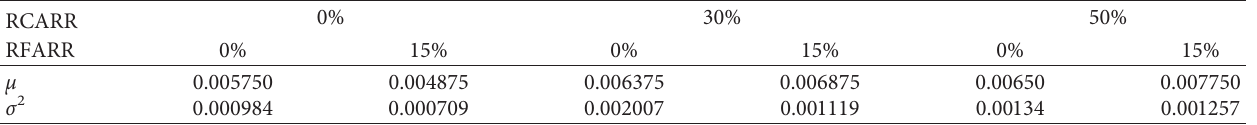
Table 3: Maximum likelihood estimation parameters of different recycled